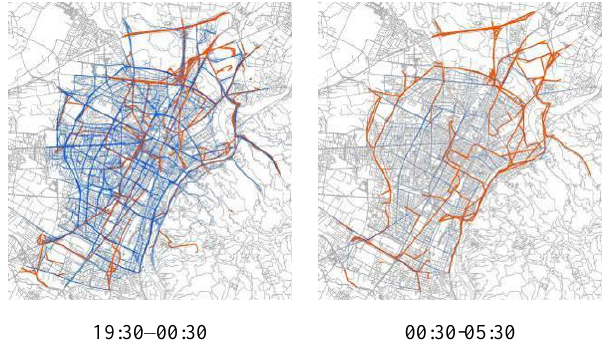
Figure 15. Different ratio between private cars (blue) and fleets (orange) paths in different periods.